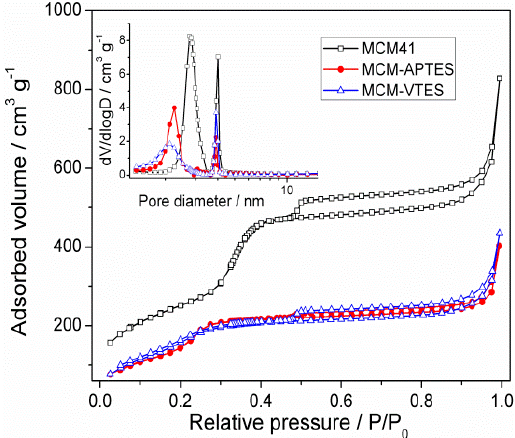
Figure 1. Nitrogen adsorption/desorption isotherms for the MCM- 41-type carriers. Insets: pore size distributions.